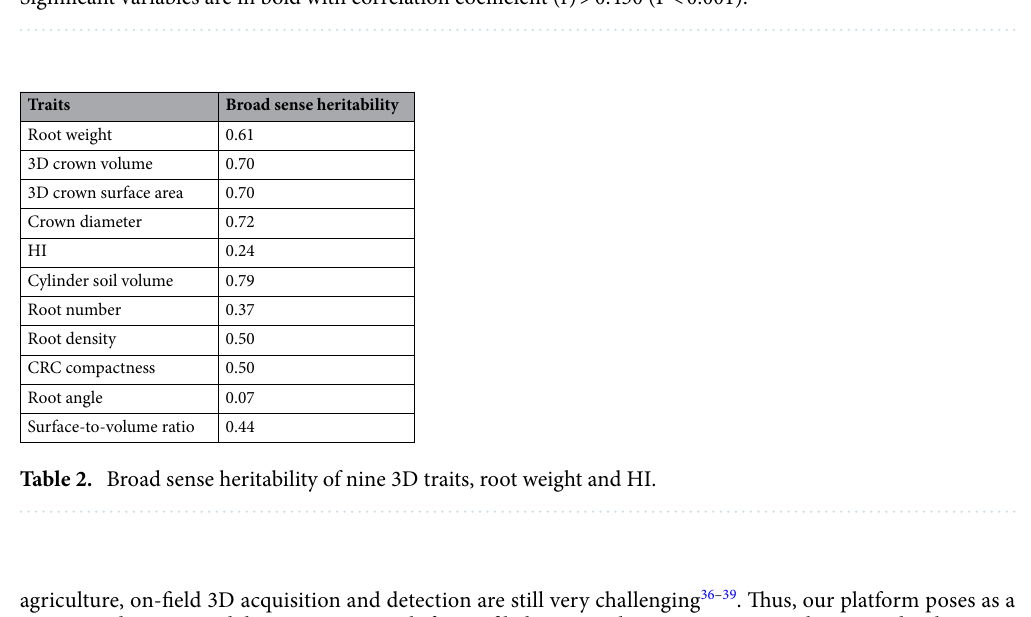
Table 1. Principle component analysis and variable contribution of nine 3D traits, root weight and HI. Significant variables are in bold with correlation coefficient (r) > 0.450 (P < 0.001).